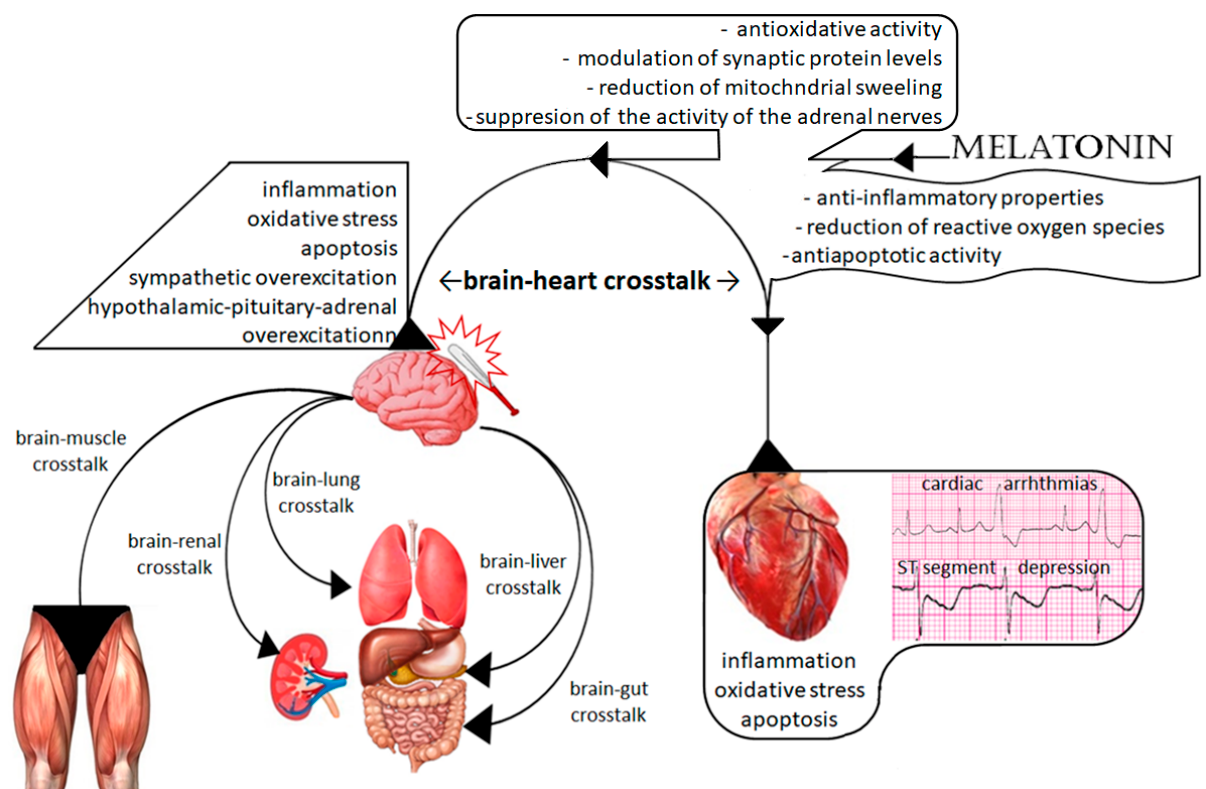
Figure 1. Scheme of brain–multiorgan interaction and the action of melatonin.